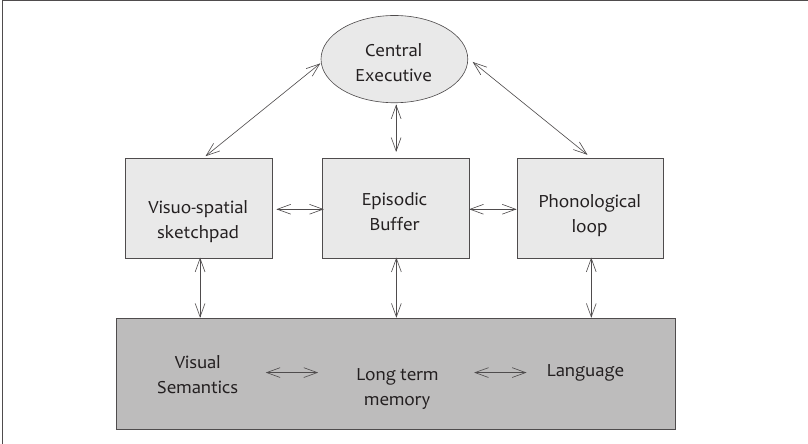
Figure 1. Schematic representation of working